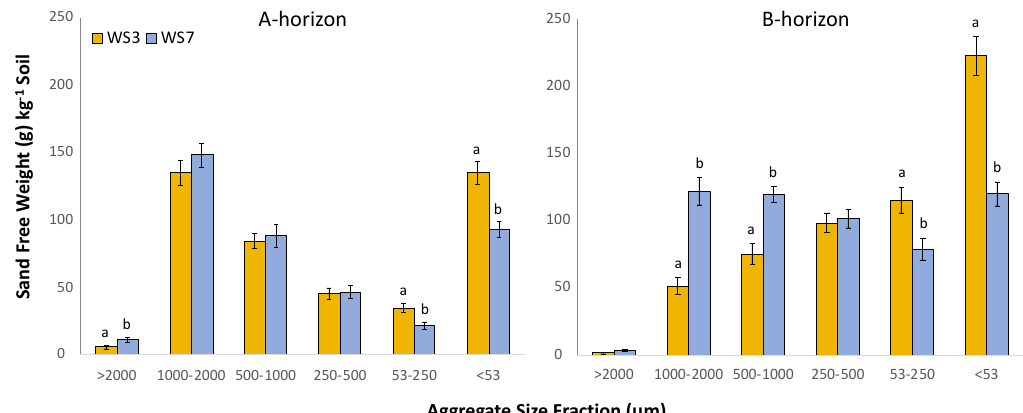
Figure 1. Sand-free weight within each aggregate size class by watershed (WS3-FERT and WS7-REF) in A-horizon and B- horizon: for each horizon, bars with different letters within each aggregate size fraction are significantly different according to Kruskal–Wallis means comparison ( p < 0.05).